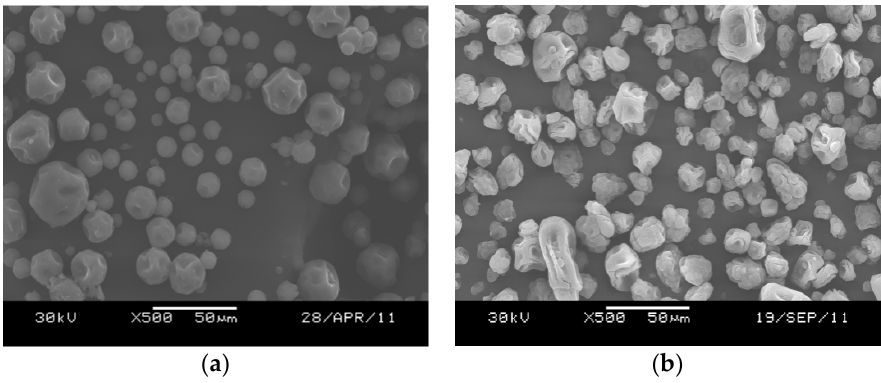
Figure 5. Morphology of the catalyst with different stirring rates: ( a ) 200 rpm; ( b ) 400 rpm.